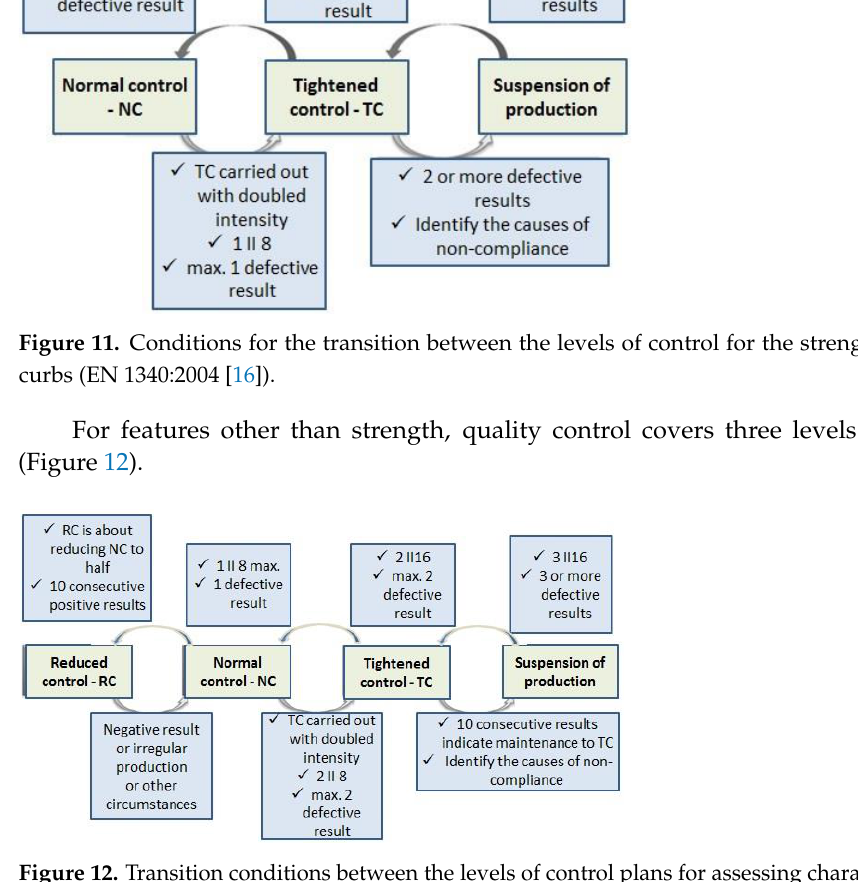
Figure 10. Conditions for the transition between the levels of strength control for precast concrete elements according to EN 13369:2018-05 [17].